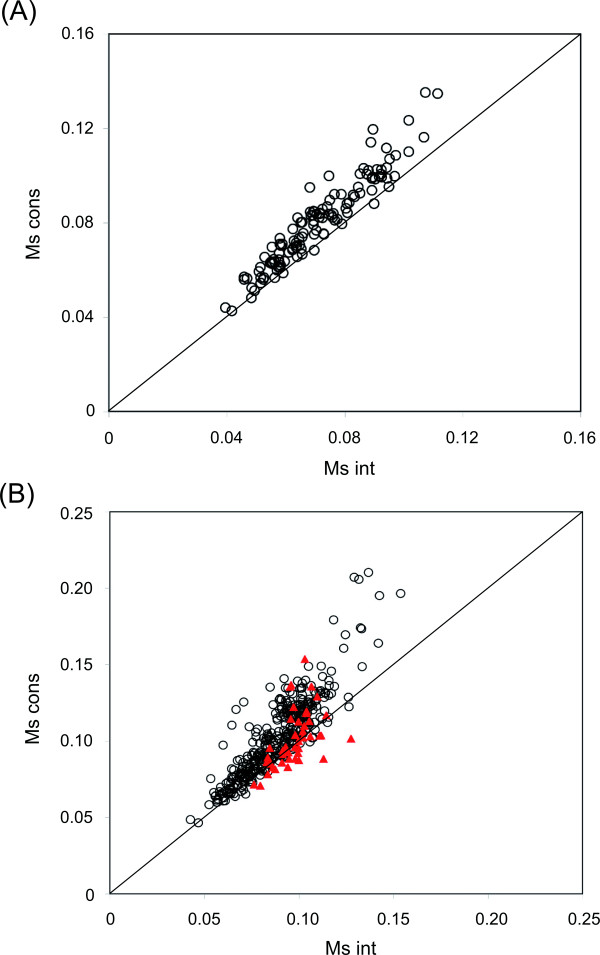
Distribution of Ms values for the conserved subset of interface residues (Ms,cons) versus that for the entire set of interface residues (Ms,int) for (A) homodimers and (B) protein-protein complexes. In (B) the antibody-antigen complexes are marked as triangles.